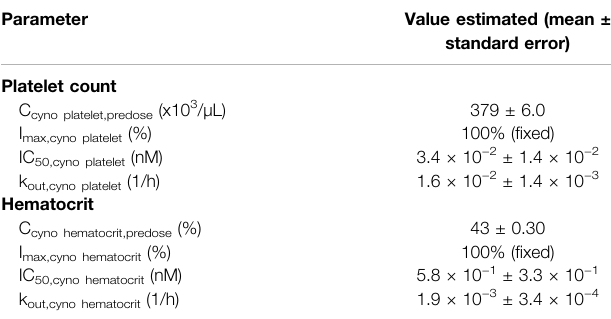
TABLE3| Pharmacodynamic parametersestimatedforhematologicalchangesin cynomolgus monkeys after intravenous administration of hFc-hIL-10 at 0.06- and 0.18-mg/kg doses given once every two weeks for three doses.